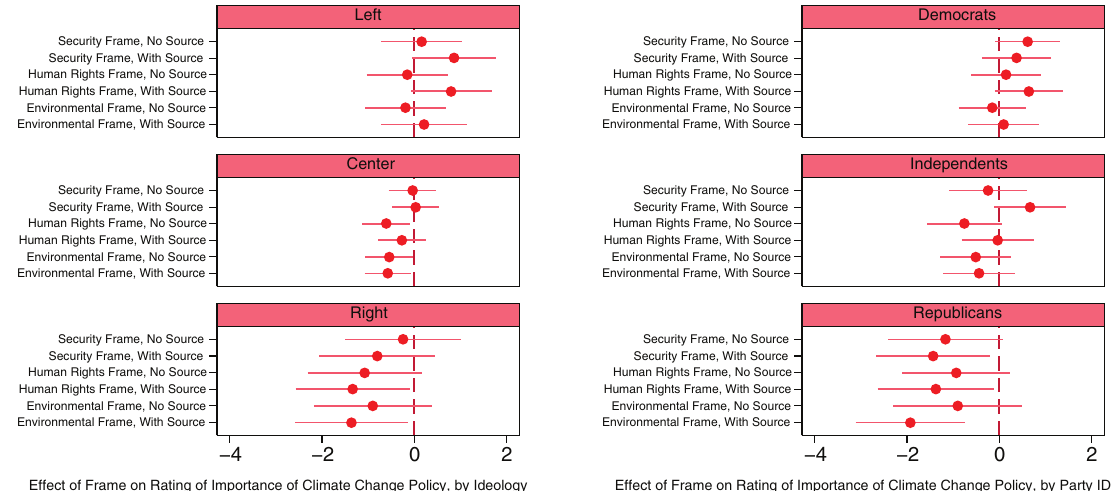
Fig 2. Climate change framesand ratings of the importance of climate change policy, over ideology and partisanship. Note: Horizontalbars indicate 90% confidenceintervals. “Left” is those who reporteda 0–10 ideologyof 0, “Center” is 5, and “Right” is